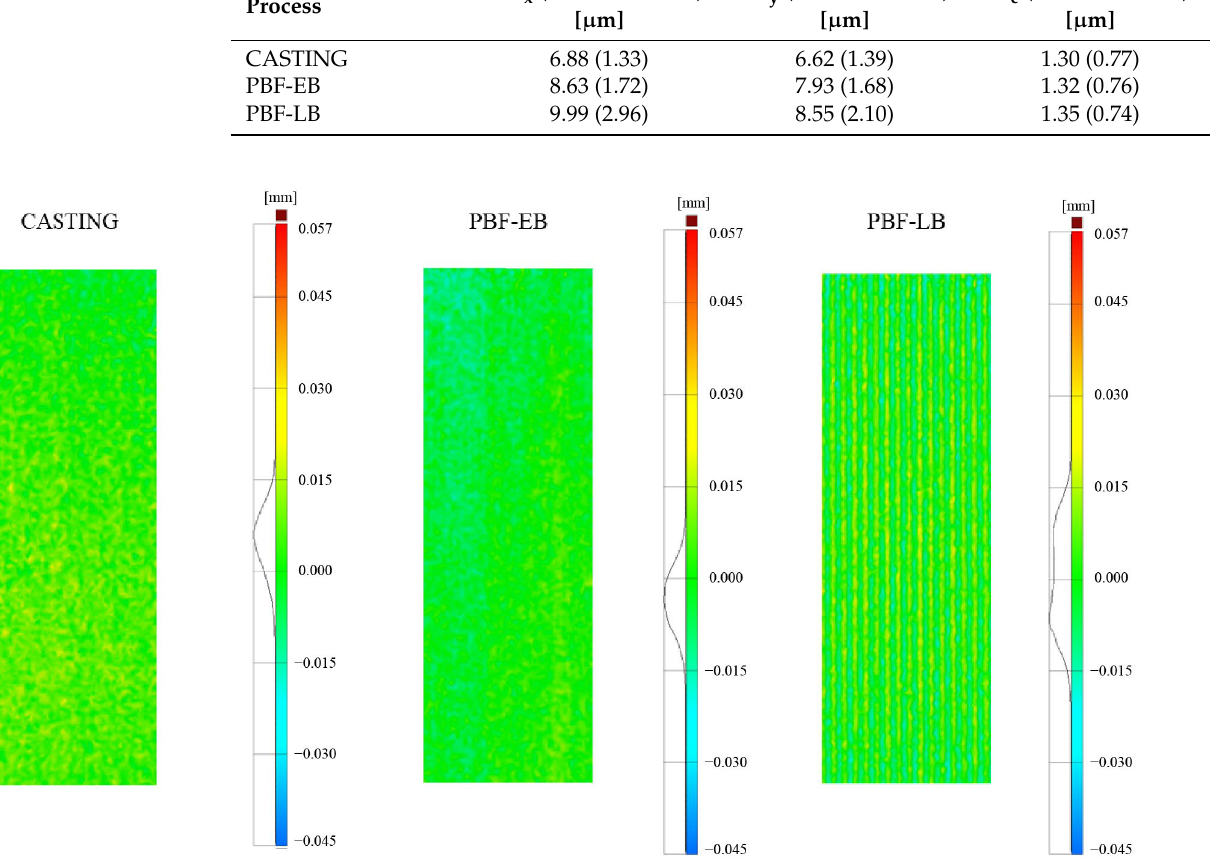
Table 5. ANOVA results of surface roughness in the two directions.